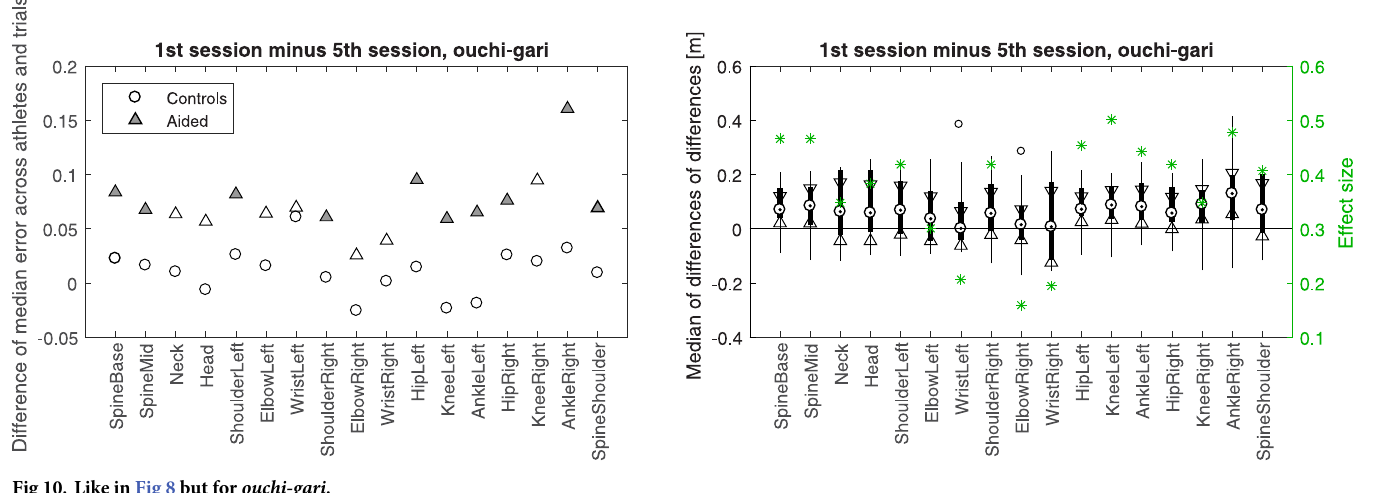
Fig 10. Like in Fig 8 but for ouchi-gari